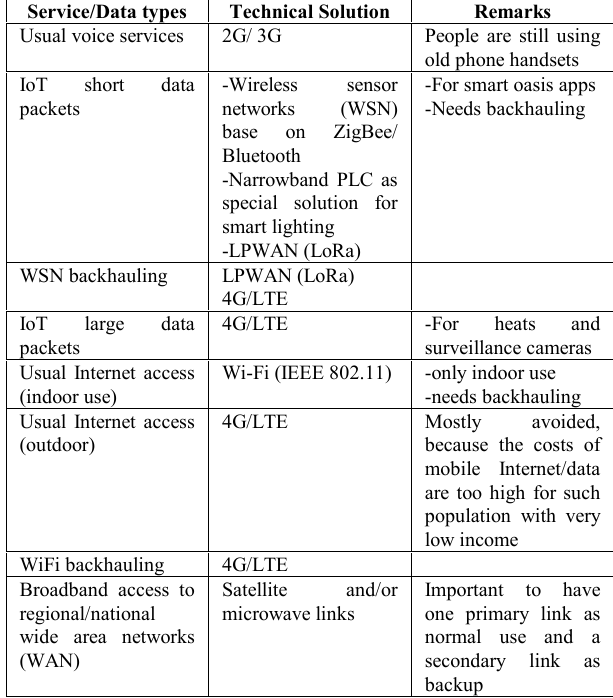
TABLE 1: Types of data flows in oasis areas and